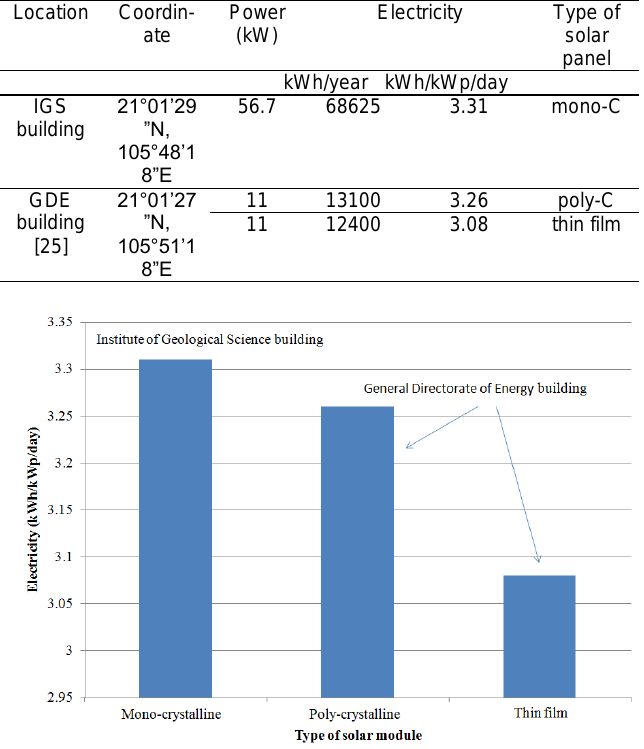
Table 3. Comparative parameters of solar power station